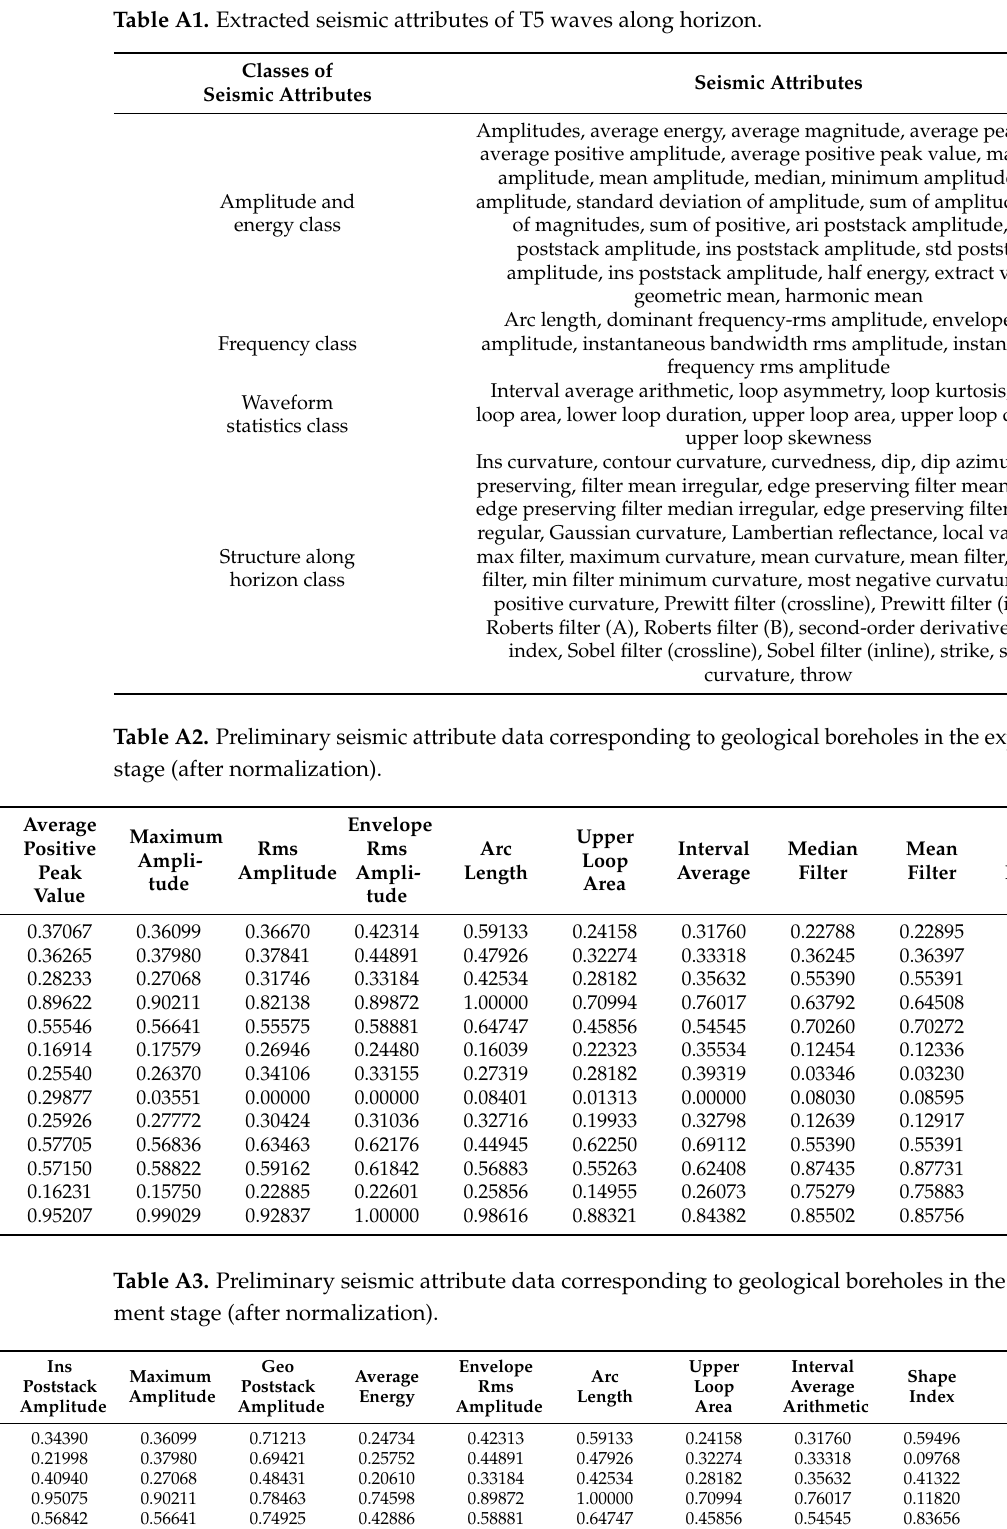
Table A1. Extracted seismic attributes of T5 waves along horizon.